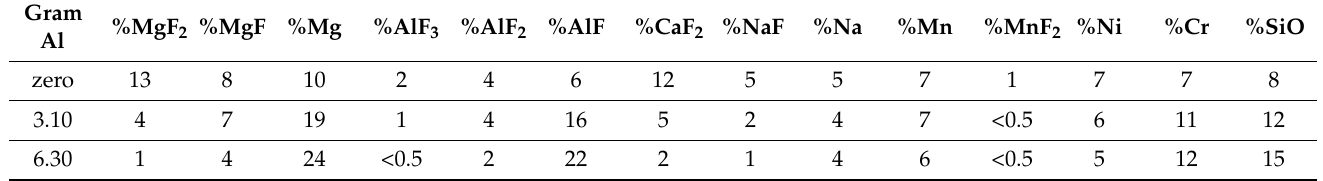
Table 7. Gas composition (volume %) output from gas-slag-metal powder equilibrium at 2500 °C